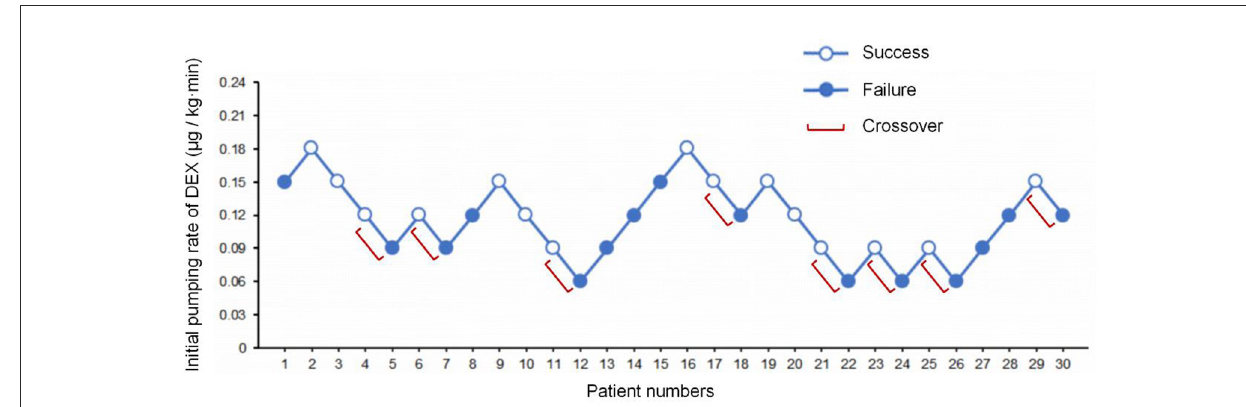
FIGURE2 The sequence of initial infusion rate of DEX administered and subsequent response (loss of consciousness) within 18min. Success – open circle; failure – filled circle.